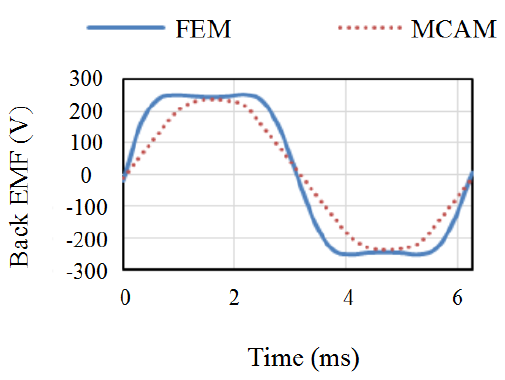
Figure 5. No-load back electromotive force (EMF) of the AFPMSM.